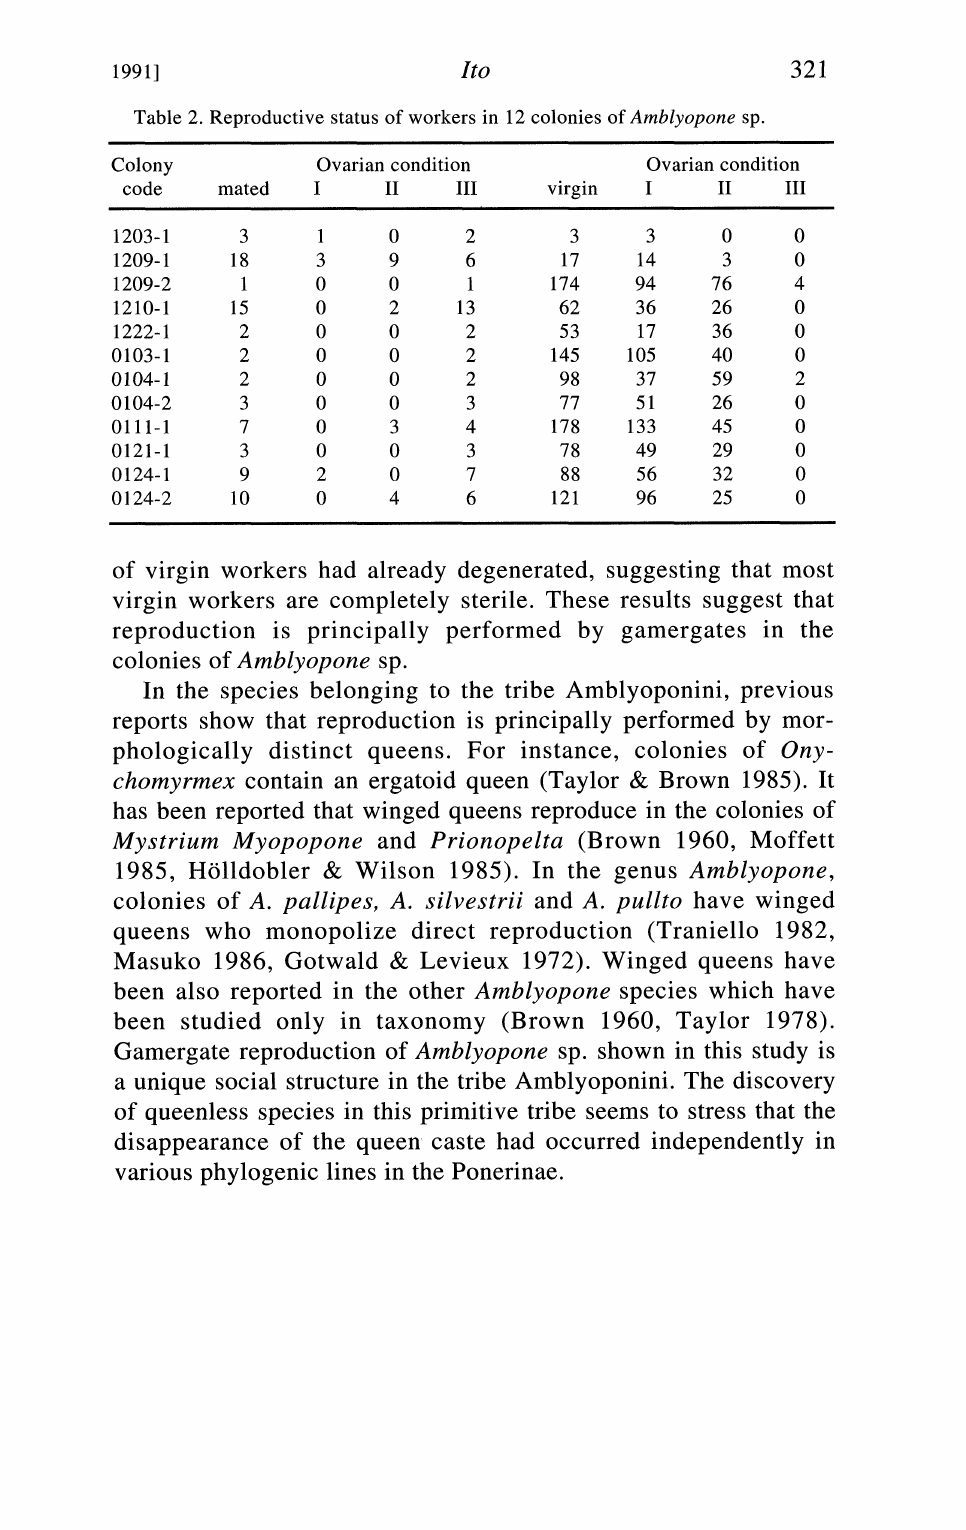
Table 2. Reproductive status of workers in 12 colonies of Amblyopone sp. Colony Ovarian condition Ovarian condition